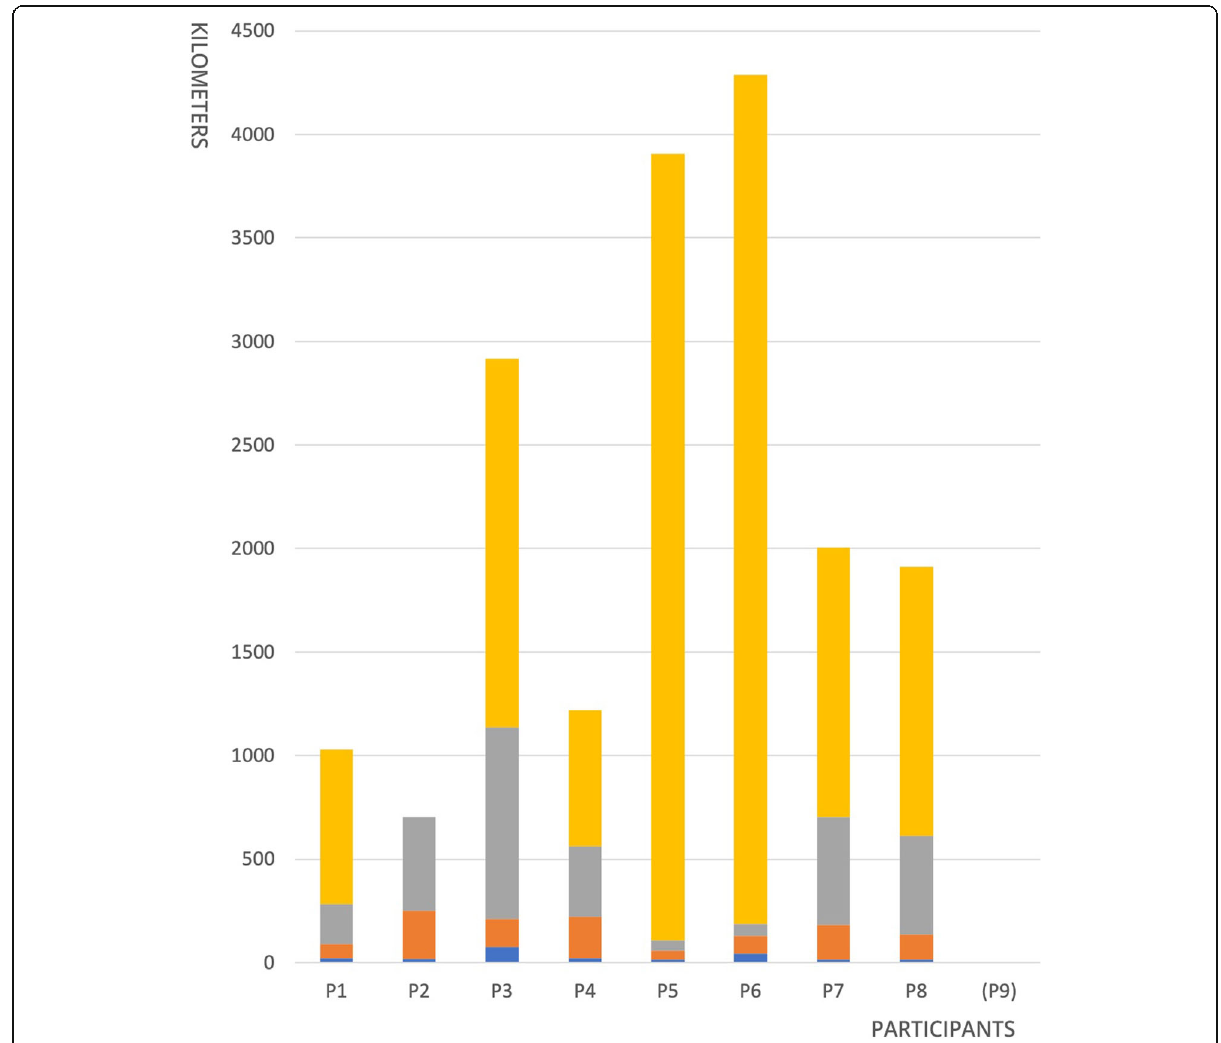
Fig. 2 Kilometre by car in